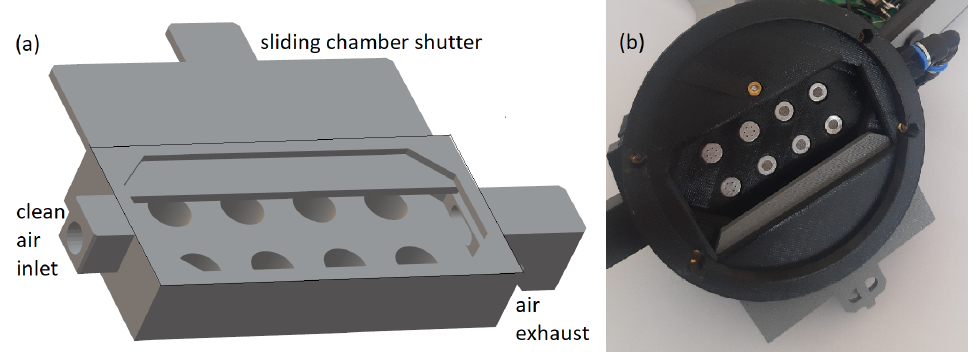
Figure 2. Electronic nose sensor chamber: ( a ) schematic driving, and ( b ) real photo. The view from the bottom when the chamber shutter is